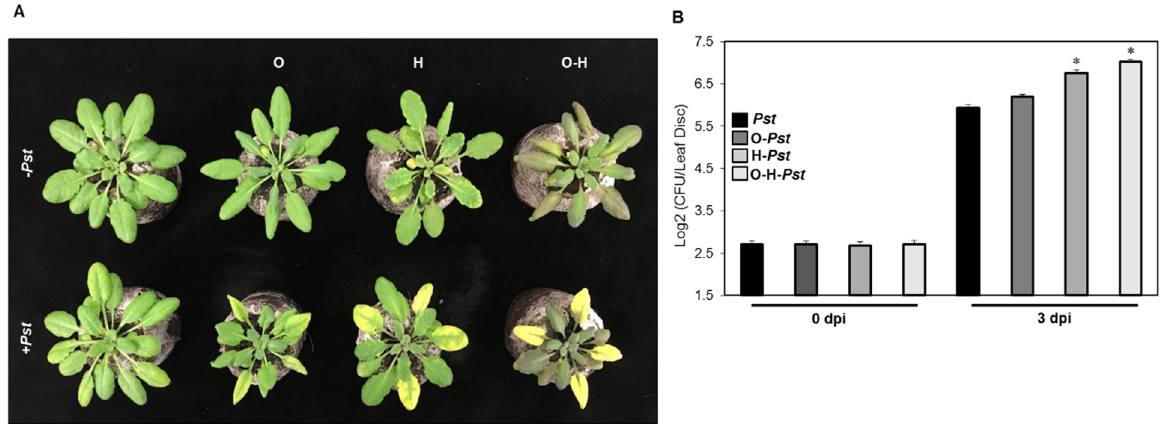
Figure 1. Effect of individual and combined osmotic and heat stresses on plant susceptibility to Pseudomonas syringae pv. tomato DC3000 ( Pst ). ( A ) Phenotype of stressed Arabidopsis (Col-0) plants. Plants were infected with Pst 16 h after the abiotic stress treatments. Photos were taken 3 d after Pst -inoculation. ( B ) Bacterial growth on leaves, quantified at 0 and 3 dpi (days post-infection) and expressed as Log2 values of colony forming units (CFU). O: osmotic stress, H: heat. Bars represent the mean and standard deviation of three biological replicates. Asterisks indicate significant differences, 1-way ANOVA; post-hoc LSD, * p < 0.05.